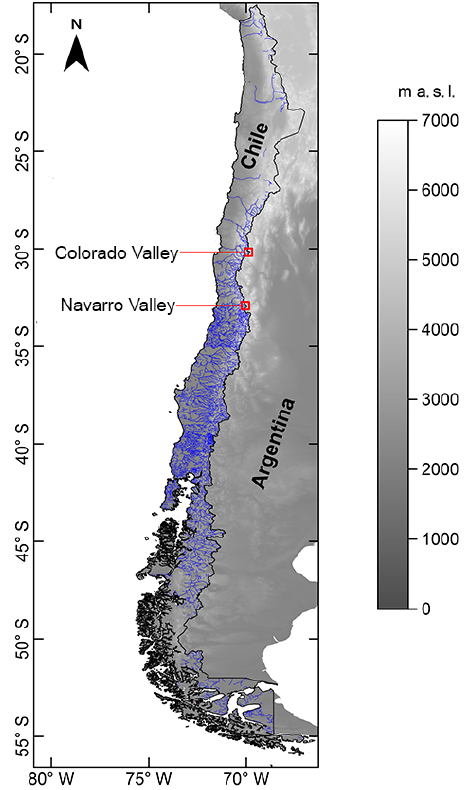
Figure 1. Location of the study sites. Drainage network, which reflects the variations in climatic–hydrologic conditions along the Chilean territory, is shown in blue.